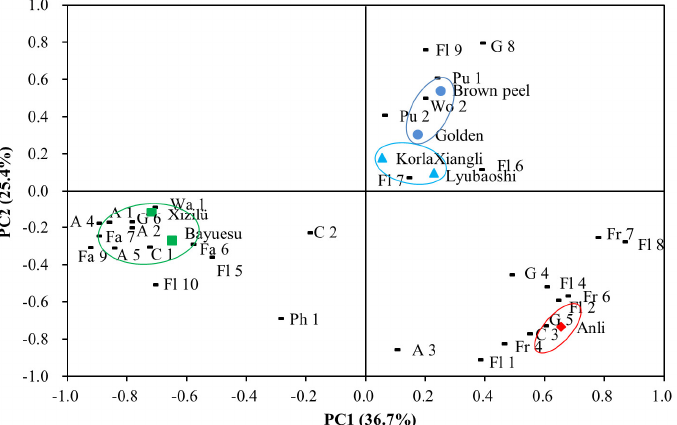
Figure 5. PCA scores plots result using seven pear flower samples as score values and OAVs of selected odorants as loading values. The odorant names correspond to the codes of compounds listed in Table 3.